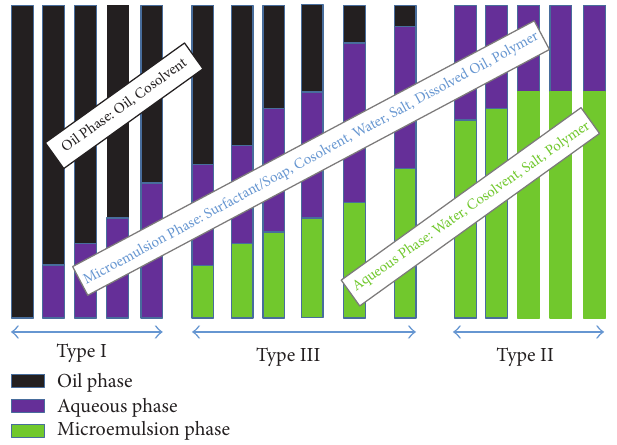
Figure 6: Effect of salinity on phase behavior